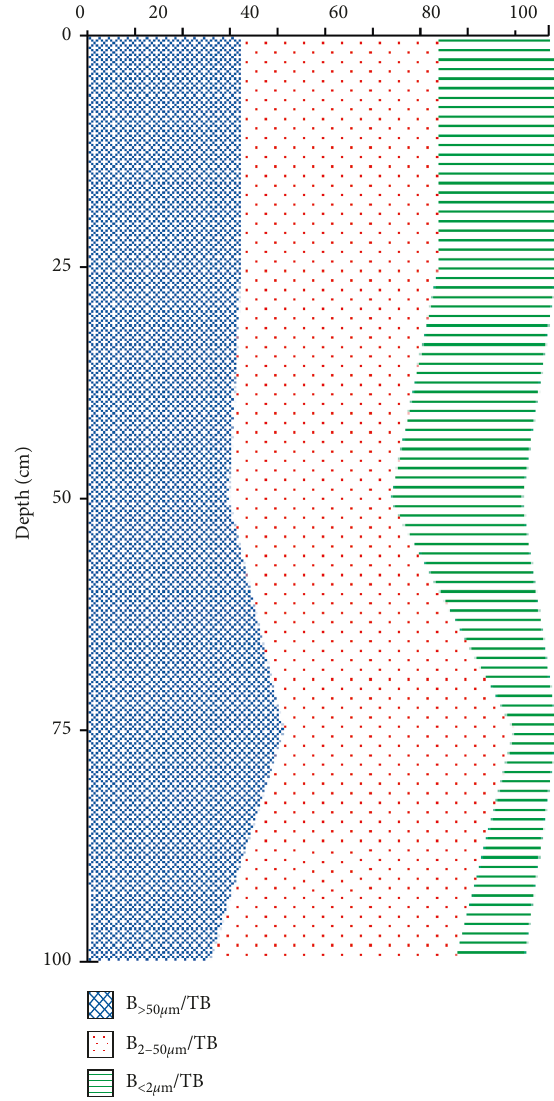
Figure 2: Depth B distribution in particle-size fractions of the studied